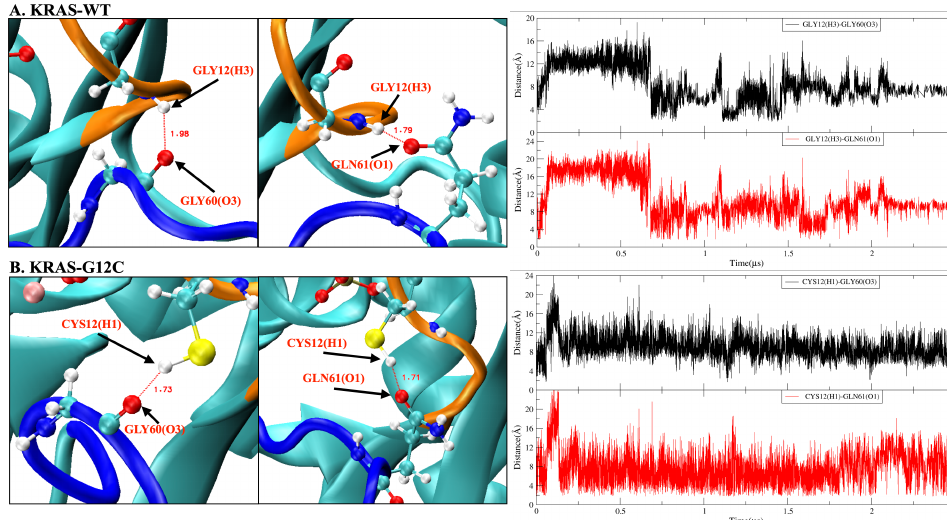
Figure A4. Hydrogen bond interactions between KRAS mutation site 12 and amino acid residues (GLY60, GLN61) of SW-II domain. ( A ) KRAS-WT case. Left side: representative snapshot of HB GLY 12 ( H 3 ) − GLY 60 ( O 3 ) and HB GLY 12 ( H 3 ) − GLN 61 ( O 1 ) , right side: time evolution of atom–atom dis- tance d ( t ) corresponding to the left side; ( B ) KRAS-G12C case. Left side: representative snapshot of HB CYS 12 ( H 1 ) − GLY 60 ( O 3 ) and HB CYS 12 ( H 1 ) − GLN 61 ( O 1 ) , right side: time evolution of atom–atom distance d ( t ) corresponding to the left